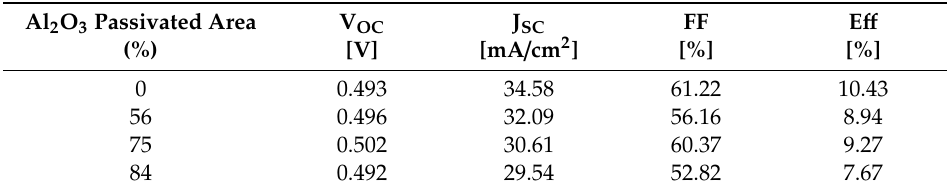
Figure 2. I–V curves of the best e ffi ciency of the CZTSSe cell device, coated with di ff erent passivation ratios. Table 1. Open circuit voltage (Voc), short-circuit current density (Jsc), Fill Factor (FF), and power conversion e ffi ciency (E ff ) of the CZTSSe devices fabricated with di ff erent closed-ratios of Al 2 O 3 passivated